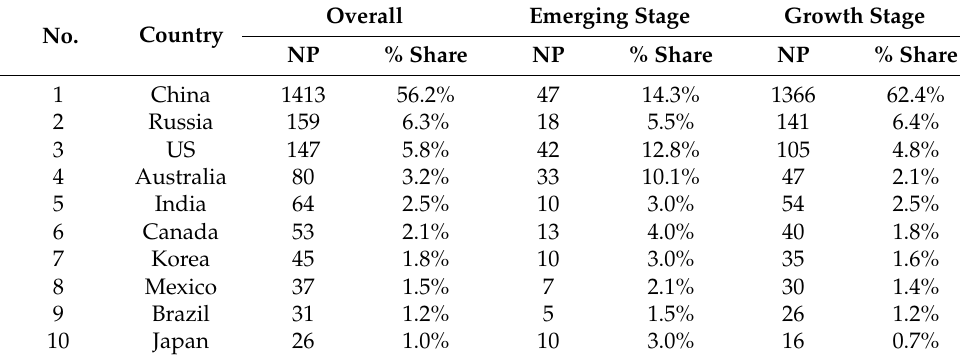
Table 4. Top ten countries in terms of number of patents